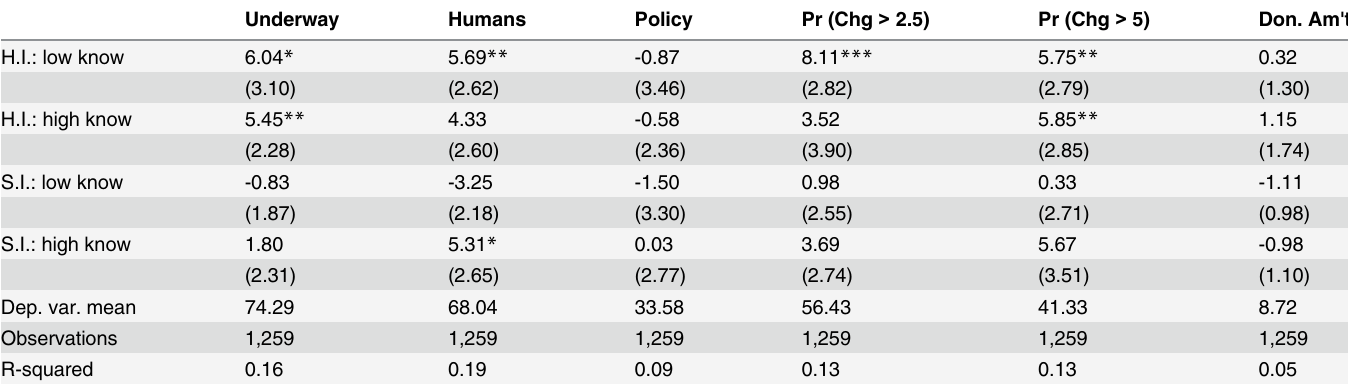
Table 5. Short-run effects of information by